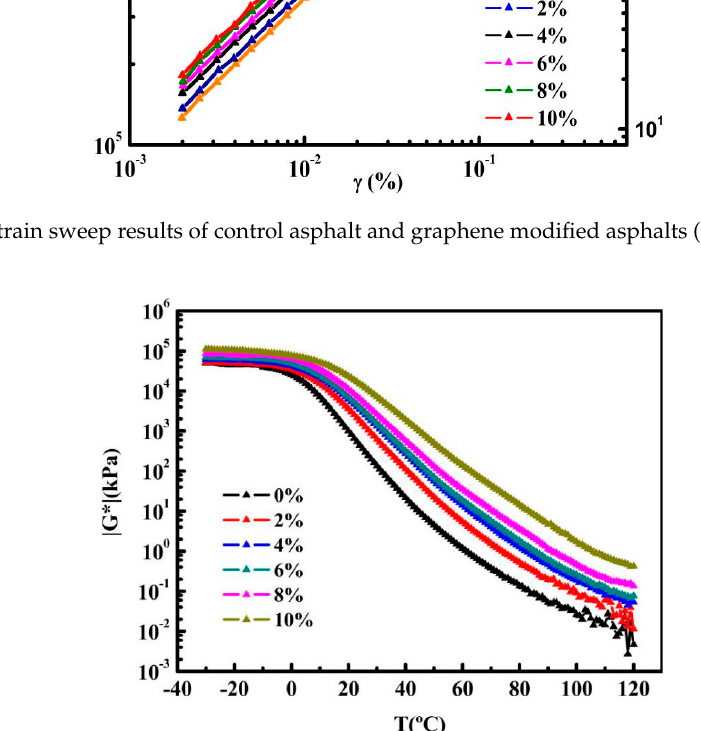
Figure 4. Strain sweep results of control asphalt and graphene modi fi ed asphalts (GMAs) at − 30 °C.